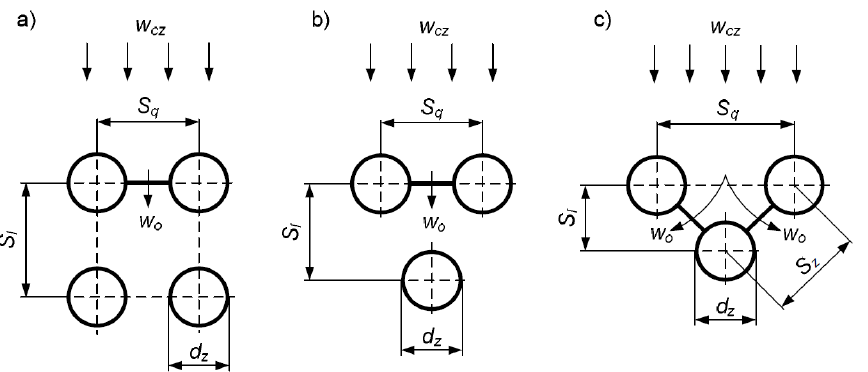
(cid:16) (cid:17) 0.5 (cid:2868).(cid:2873) ≥ 0.5 ∗ + 1 2 ∗ S q ; ≥ 0.5 ∗ (cid:4672)2 ∗ (cid:3020) (cid:3292) + 1(cid:4673) ; d z d z (cid:3031) (cid:3301) (cid:3031) (cid:3301)